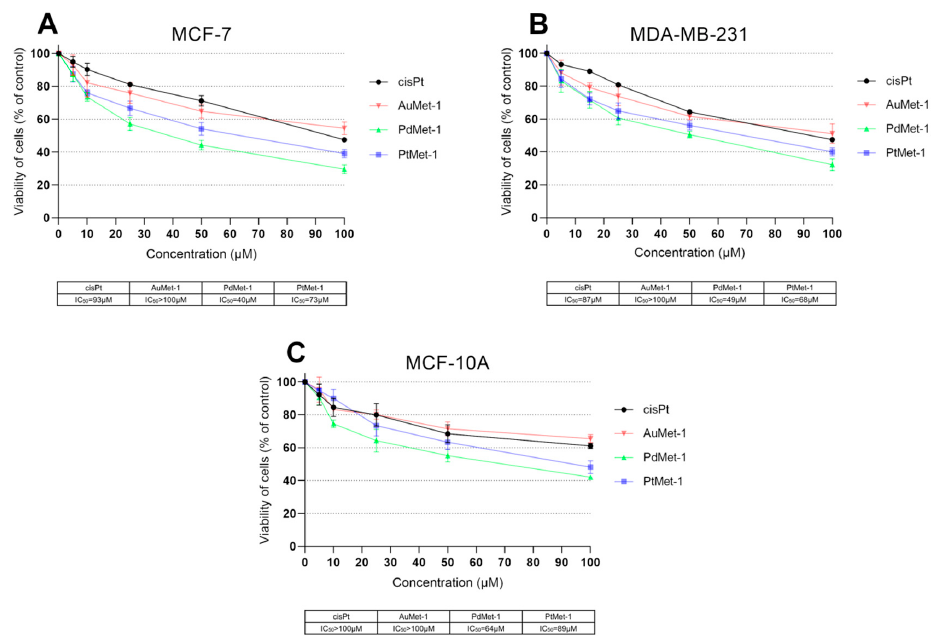
Figure 2. Viability of MCF-7 ( A ) and MDA-MB-231 ( B ) breast cancer cells and normal human breast epithelial cell MCF-10A ( C ) treated for 24 h with different concentrations of the tested compounds: AuMet-1, PdMet-1, PtMet-1 and cisplatin. Mean values ± SD from 3 independent experiments (n = 3) done in duplicate are presented. Molecules 2020 , 25 , x FOR PEER REVIEW